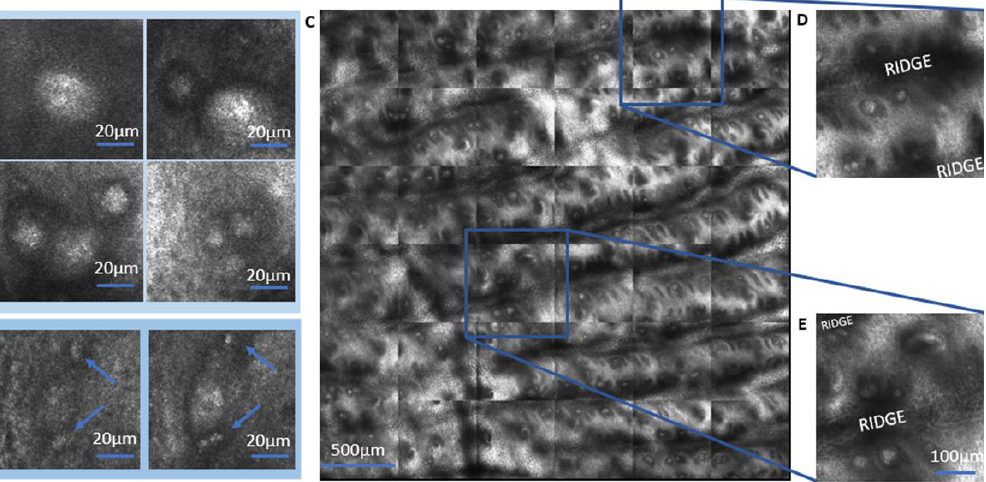
Figure 2. LSM observations of Meissner corpuscles. ( A ) The MCs can be single, in pairs or triplets in the same papilla occupying variable volume. ( B ) Proximity of MCs (center of the figure) and blood capillaries (marked with blue arrows) is often observed. ( C ) The VivaBlock ® image of a 9 mm² area demonstrates that MCs are most often found close to the ridges ( D , E ). Table 1. Morphological information regarding the participants in this study. Above MCs, the thickness of the epidermis was reduced, and the epidermis protruded into the stratum